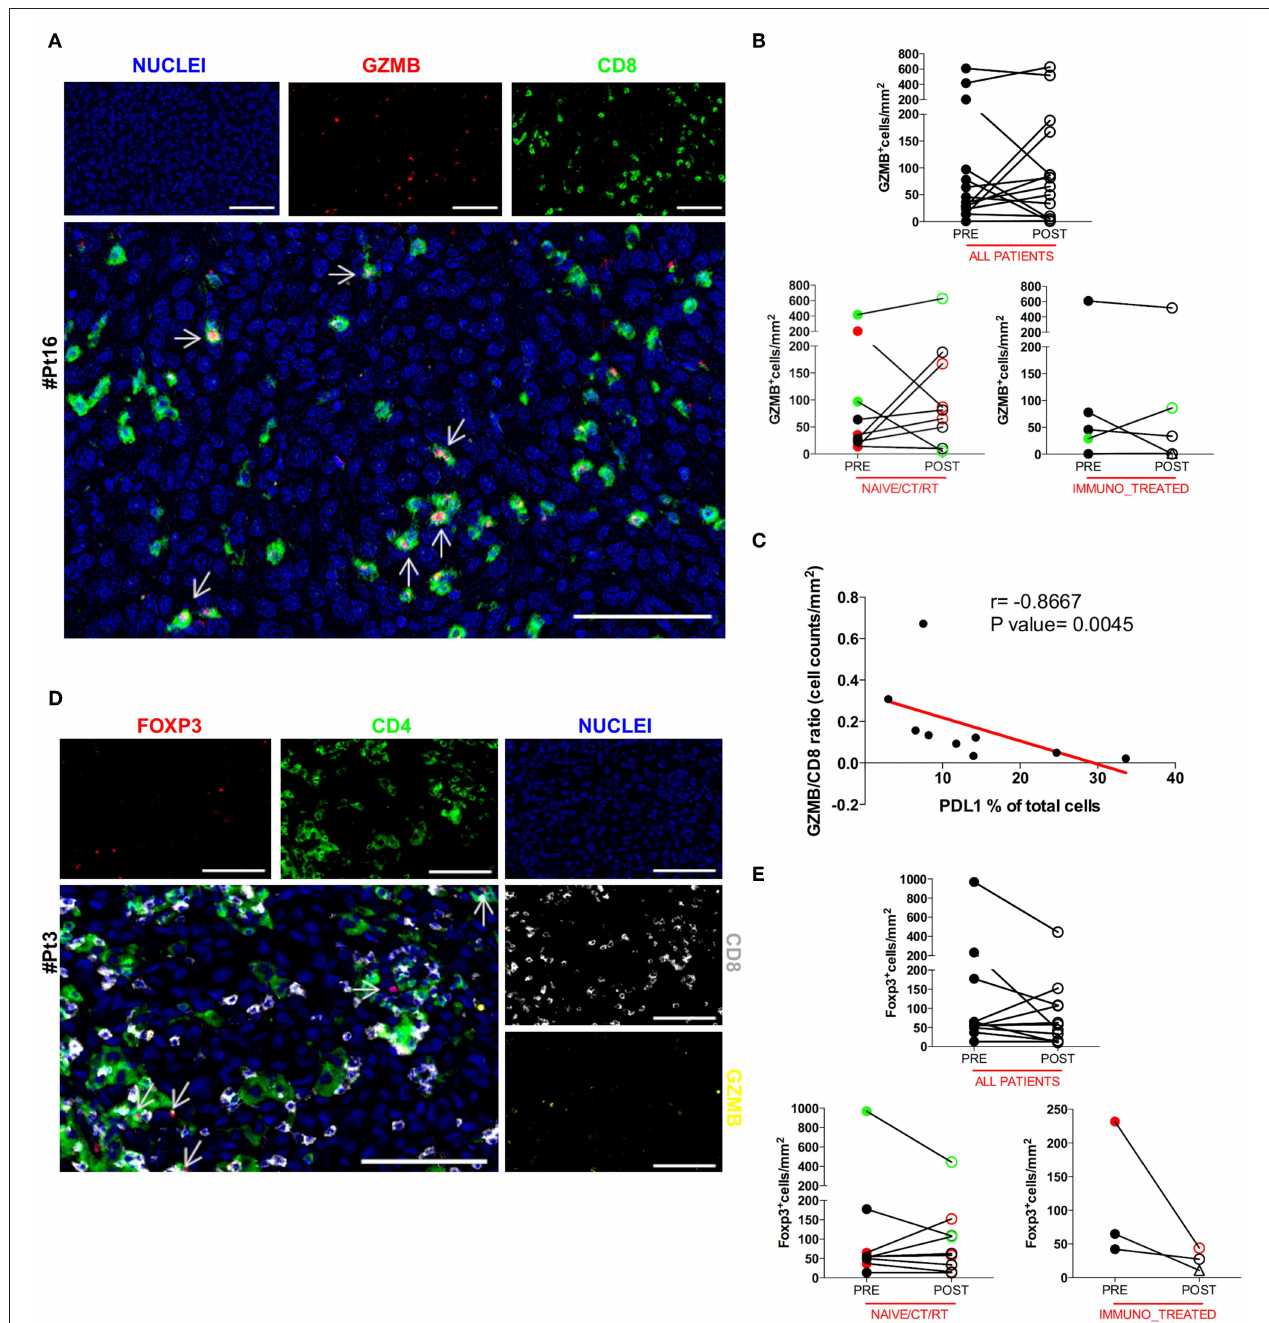
FIGURE 3 | Analysis of the functional phenotype of intratumoral CD8 + and CD4 + T cells. The co-expression of GZMB and CD8 was evaluated by sequential IHC. AEC color signals were extracted from each digitized single-marker image by color deconvolution, followed by pseudo-coloring. A representative image is shown (Pt#16). Nuclei (blue), GZMB (red), CD8 (green). Scale bars, 100 µ m (A) . The GZMB expression between matched pre- and post-therapy samples, either in the total patient cohort or in any of the defined patient groups is illustrated in graphs ( all patients n = 14 p = 0.5830, naïve/CT/RT n = 9 p = 0.2500, immuno_treated n = 5 p = 0.4375) (B) . Correlation between the GZMB ÷ CD8 ratio and the percentage of PDL1 over total cells in the naïve/CT/RT patient cohort (Spearman r =− 0.8667, ** p = 0.0045) (C) . FFPE pre-therapy sections were analyzed by multiplex IHC. Results from a representative patient (Pt#3) are shown. Nuclei (blue), GZMB (yellow), CD8 (gray), CD4 (green), and Foxp3 (red). Scale bars, 100 µ m (D) . Changes in the expression of Foxp3 marker in matched pre- and post-therapy lesions are shown in graphs for all patients ( n = 12, p = 0.2334) as well as for the two defined patient sub-groups ( naïve/CT/RT n = 9, p = 0.7334, immuno_treated n = 3, p = 0.2500) (E) . CR and PR Patients are displayed in green, SD in black, and PD in red. Open circles denote on-treatment samples, open triangles post-treatment ones. Statistical comparisons are based on the non-parametric two-tailed Wilcoxon signed-rank test. Only values statistically significant are reported.